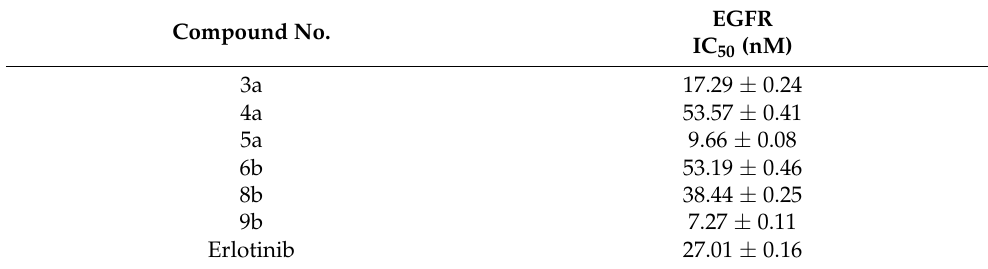
Table 4. In vitro enzymatic inhibitory activity against EGFR